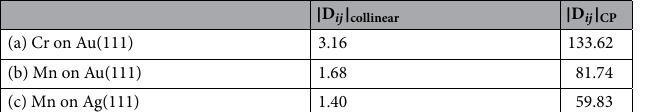
Table 2. Comparison of the strength of the DMI between the collinear and CP configuration, in meV. Note that (a), (b) and (c) denotes the systems shown in Fig. 1 of a triangular trimer of Cr on Au(111) surface, Mn on Au(111) and Ag(111) surfaces,